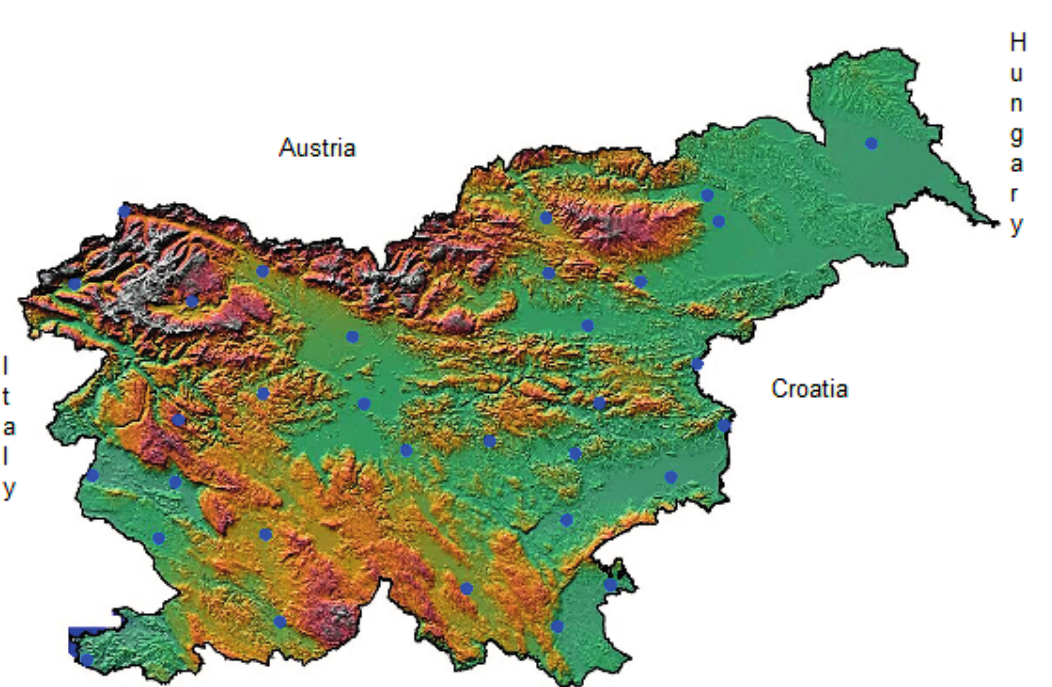
Figure 1. Meteorological stations in Slovenia